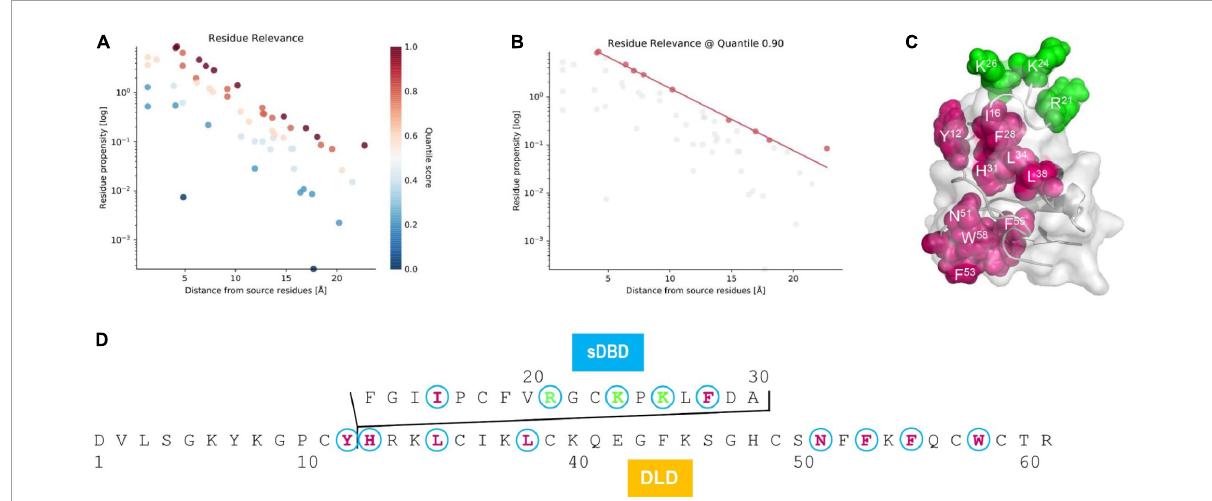
FIGURE5 Residue relevance between sDBD and DLD subdomains of mehamycin. (A) The hotspot view of high or low connectivity to the source sites (R 21 , K 24 , and K 26 ). All data points were plotted as propensity over distance from source, in which hotspots and coldspots are colored according to their quantile scores. (B) The relevant residues view at 0.90 quantile score cut off. (C) Mapping of relevant residues (red) to the source sites (green) on the structure of mehamycin. (D) Mapping of relevant residues (red) to the source sites (green) on the sequence of